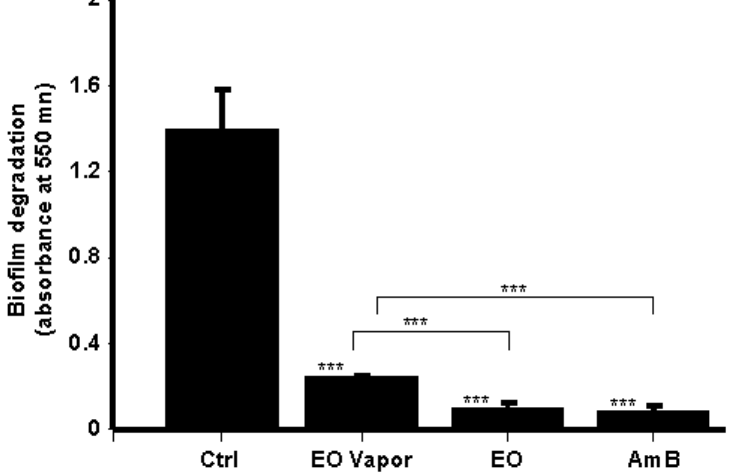
Figure 5. Mentha × piperita essential oil decreased biofilm mass. C. albicans was cultured in a 3D porous scaffold in Sabouraud medium for 3 days to promote biofilm formation and maturation. The resulting biofilms were exposed or not to either 10 µ L/mL of EO or 5 µ g/mL of AmB for 24 h. Following incubation, the samples were subjected to an MTT assay. Absorbance at 550 nm was measured, with the results presented as the means ± SD of four separate experiments. The levels of significance for biofilm degradation in the presence or absence of the EO or AmB were calculated; *** p < 0.001. The free asterisks refer to the statistical difference when comparing EO effects to control. The bars with asterisks showed the comparison of EO vapor to the EO liquid, and to the